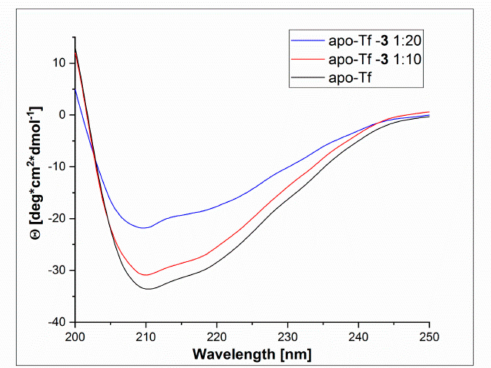
Figure 7. Circular dichroism -CD spectra of apo-Tf – 3 systems under physiological conditions (PBS, pH = 7.40, T = 310 K) (C apo-Tf = 5 × 10 − 6